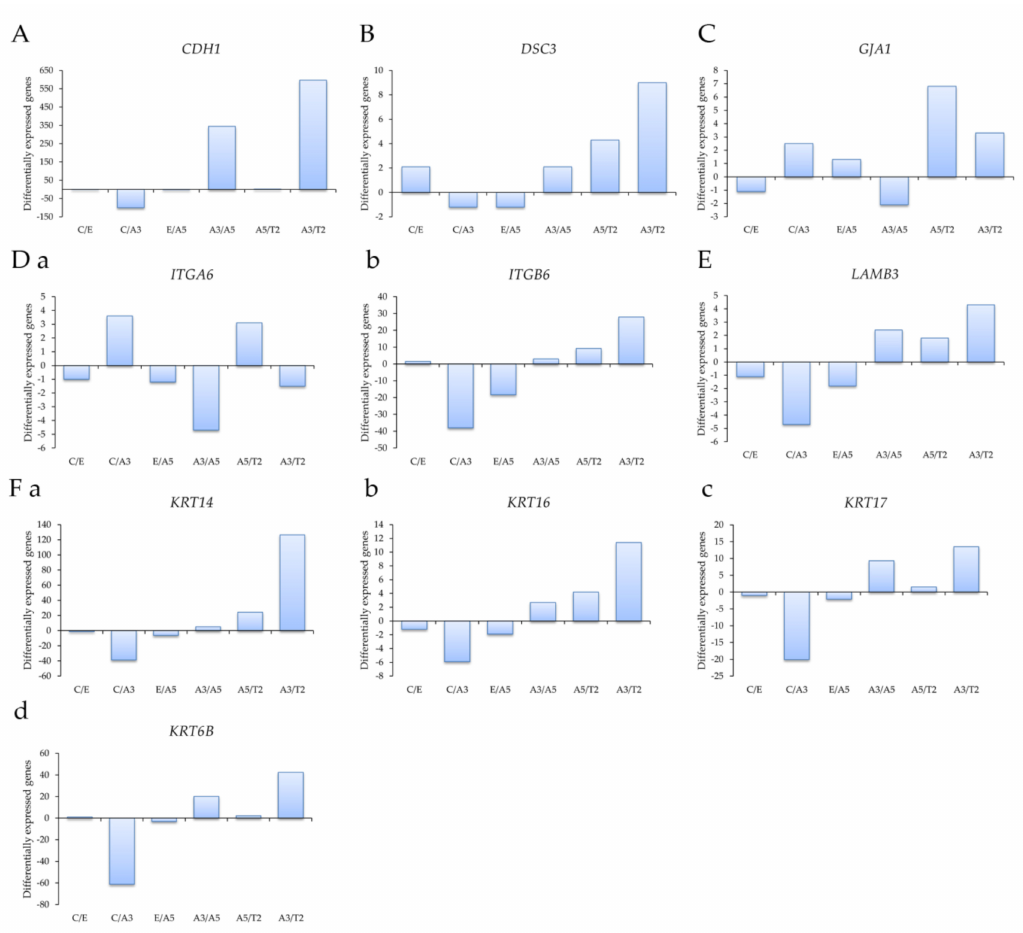
Figure 2. Profiling of differentially expressed genes obtained through an Affymetrix array (U133A) data comparing ( A ) the E-cadherin gene CDH1 , ( B ) the desmocollin 3 gene DSC3 , ( C ) the gap junction protein, alpha 1 gene GJA1 , ( D ) ( a ) the Integrin alpha 6 gene ITGA6 , ( b ) the Integrin beta 6 gene ITGB6 , ( E ) the laminin beta 3 gene LAMB3 , and ( F ) the Keratin genes ( a ) KRT14 , ( b ) KRT16 , ( c ) KRT17 , and ( d ) KRT6B in the following cell lines: MCF-10F/Estrogen (C/E); Control/Alpha3 (C/A3); Es- trogen/Alpha5 (E/A5); Alpha3/Alpha5 (A3/A5); Alpha5/Tumor2 (A5/T2) and Alpha3/Tumor2 (A3/T2). The graphs were obtained from a Cluster-dendrogram repository of gene expression from our laboratory for this